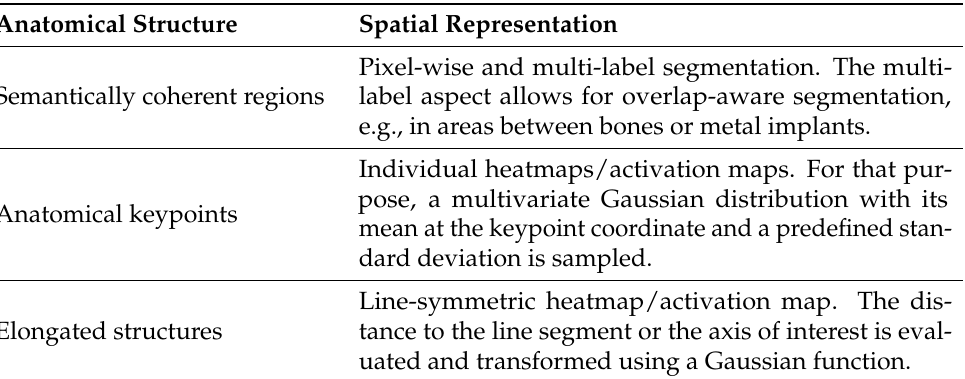
Table 1. Mathematical representation of the relevant anatomical structures that allow subsequent optimization and geometric